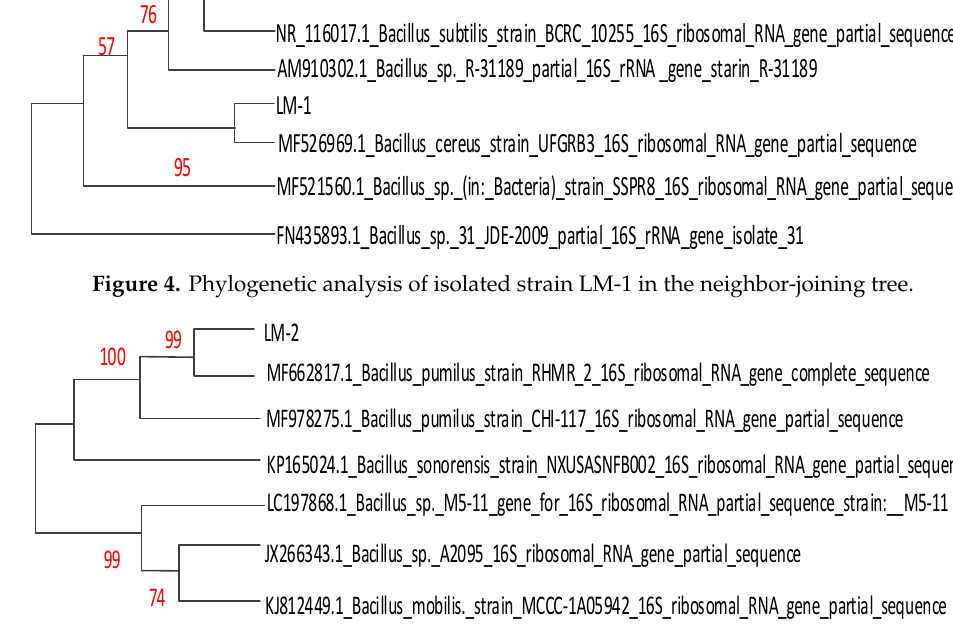
Figure 5. Phylogenetic analysis of isolated strain LM-2 in the neighbor-joining tree.